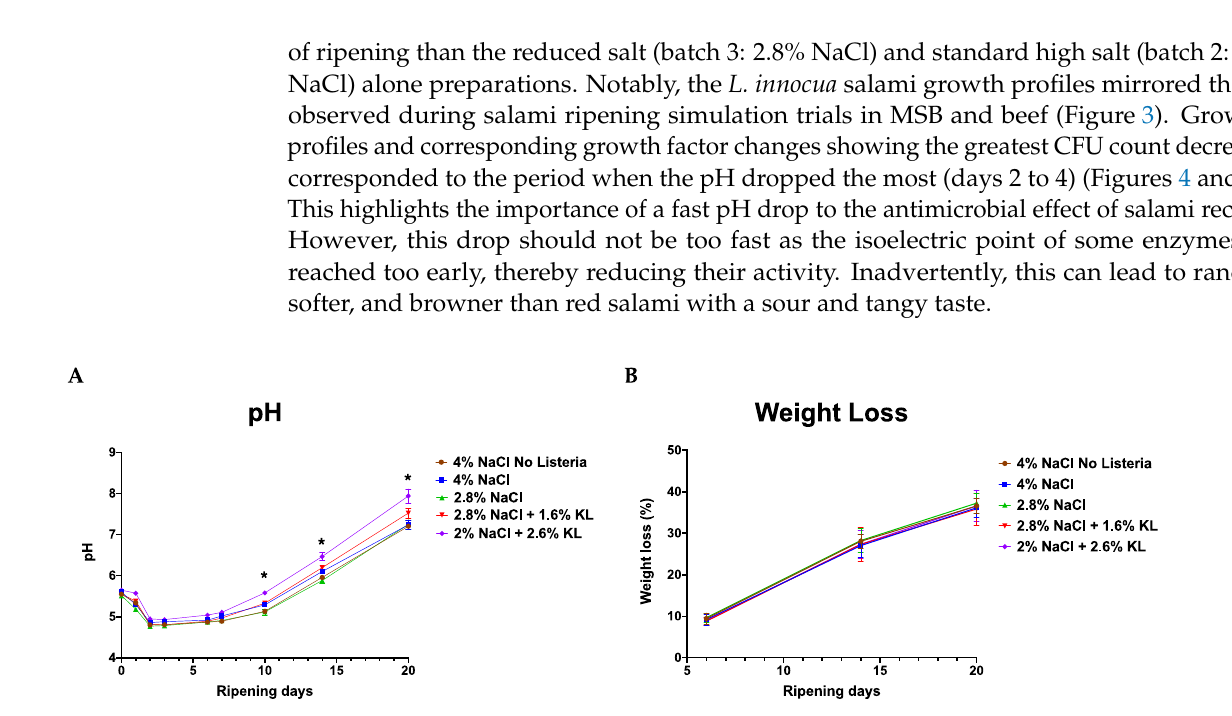
Figure 5. The ( A ) pH and ( B ) weight loss profiles during ripening of salami batches prepared with different NaCl and KL levels and combinations. Both pH and weight loss profiles were comparable between the different salami treatments albeit higher in the KL-treated salami at some stages. Data are mean pH ( n = 6 per batch) and weight loss readings ( n = 7 per batch) from two separate salami ripening trial repetitions observed during 20 days of salami ripening. * Indicates significant difference between salami batches ( p < 0.05 based on one-way ANOVA and Tukey post-hoc test pairwise comparison of the salami batches).